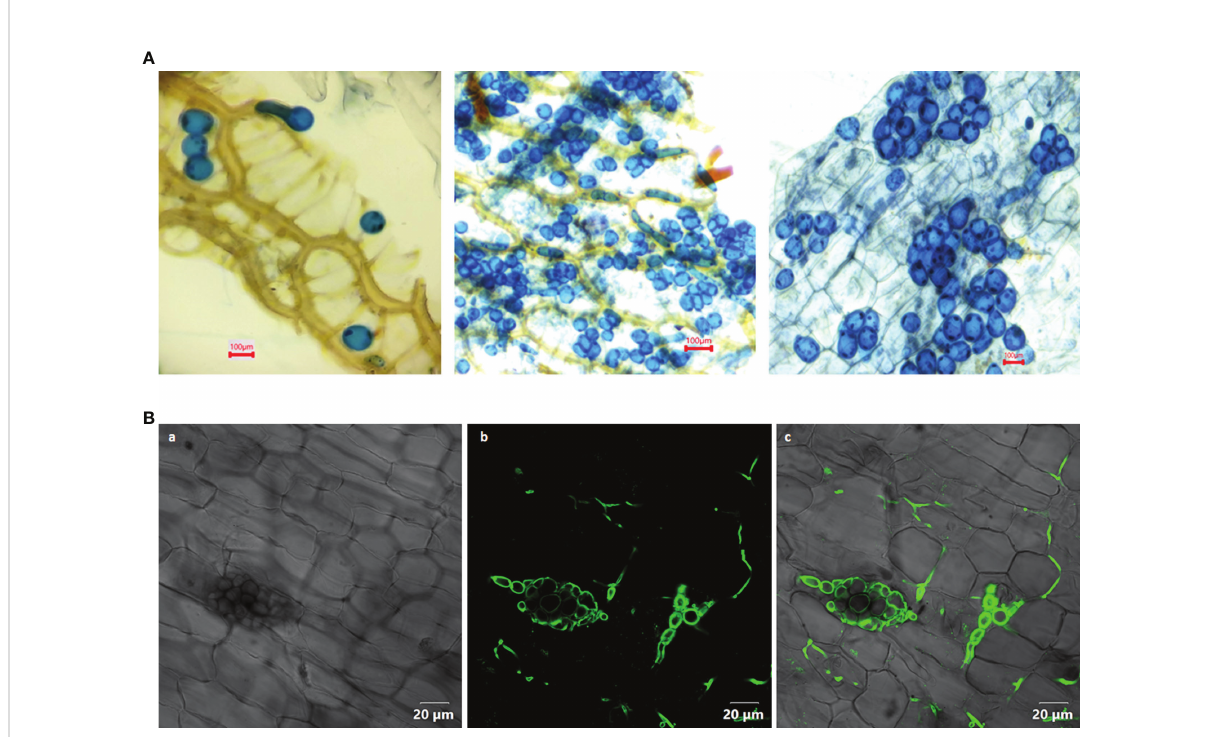
FIGURE 1 (A) Colonization of Piriformospora indica in the root cortical cells of Piper nigrum L. cv. Panniyur 1. Pear shaped chlamydospores were visualized at 20 th DAI under 40x, bright fi eld microscope (euromex model no: IS.1153-EPL-DF, Holland). (B) Confocal analysis (OLYMPUS FV3000, Tokyo, Japan) of P. indica spores stained with WGA-AF 488, indicating its colonization in the roots of P. nigrum 20 days post co- cultivation. (a) Bright fi eld image (b) WGA-AF 488 stained spores and intercellular hyphae excited at 488 nm (c) Overlay with bright fi eld